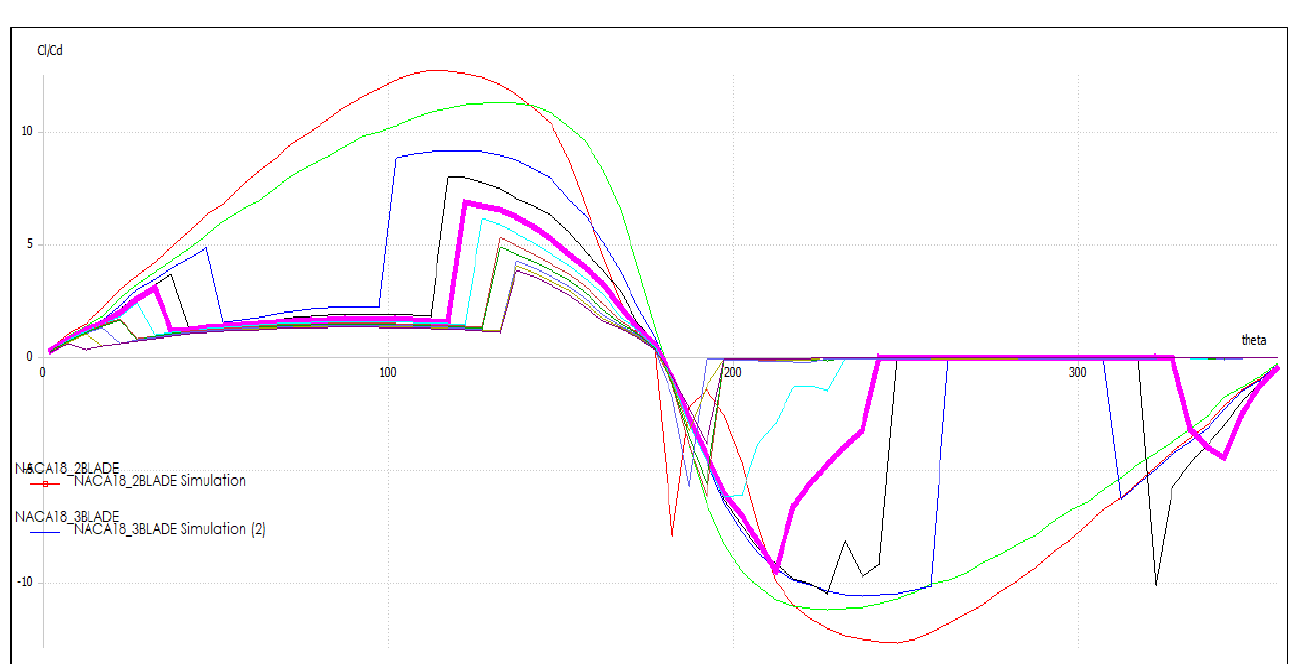
Figure 29. Cl/Cd vs theta plot of top-section for TSR 3